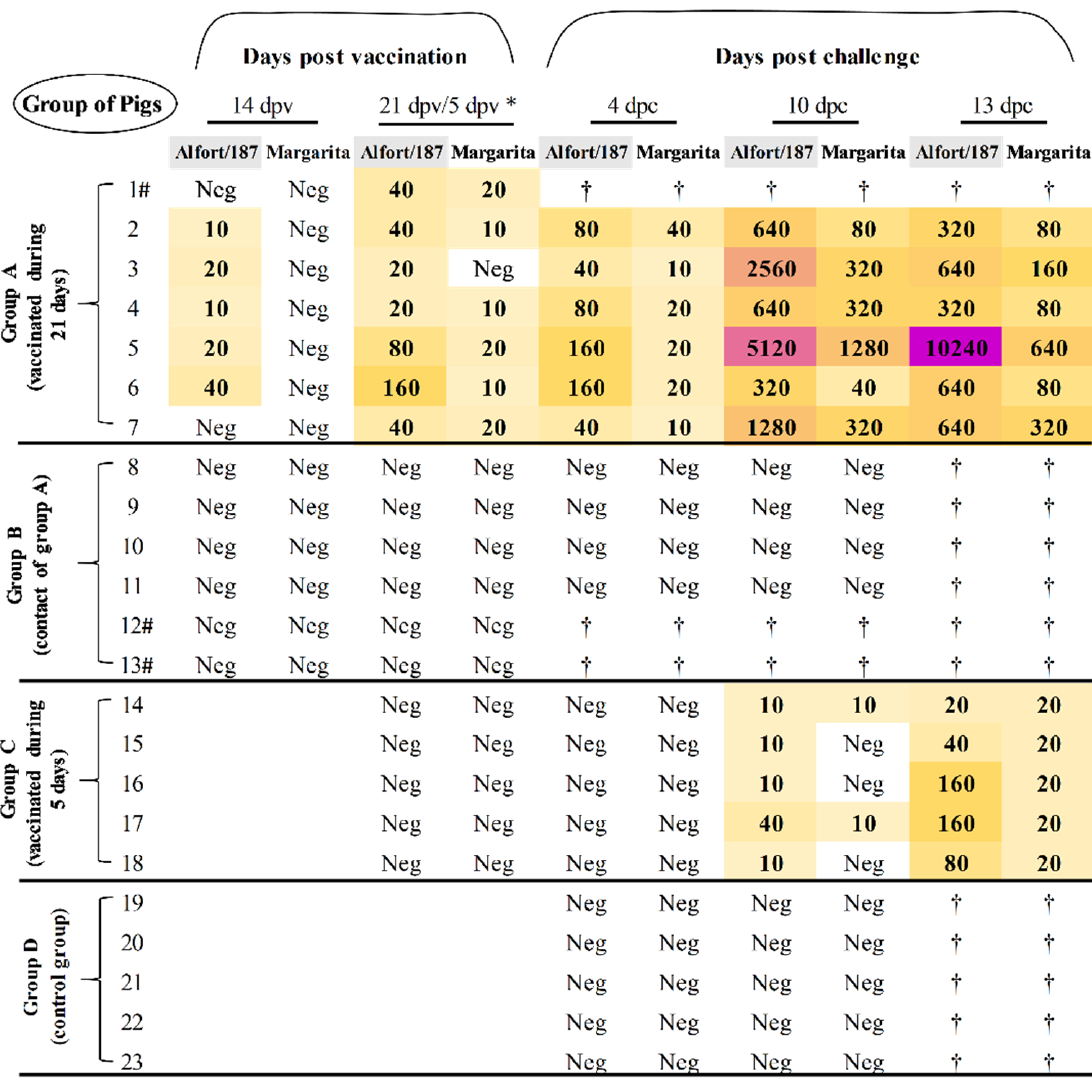
Figure 5. Determination of the neutralising antibody response during the trial. The neutralising antibody titres after vaccination and challenge were evaluated by NPLA. Neg: The sample was negative for NPLA test; † symbol indicates that the animal was euthanized before this time point; asterisk symbol (*) indicates 21 dpv for groups A and B, and 5 dpv for groups C and D. Symbol (#) indicates animals that were euthanized at the day of challenge, according to the experimental design, see Materials and methods section.